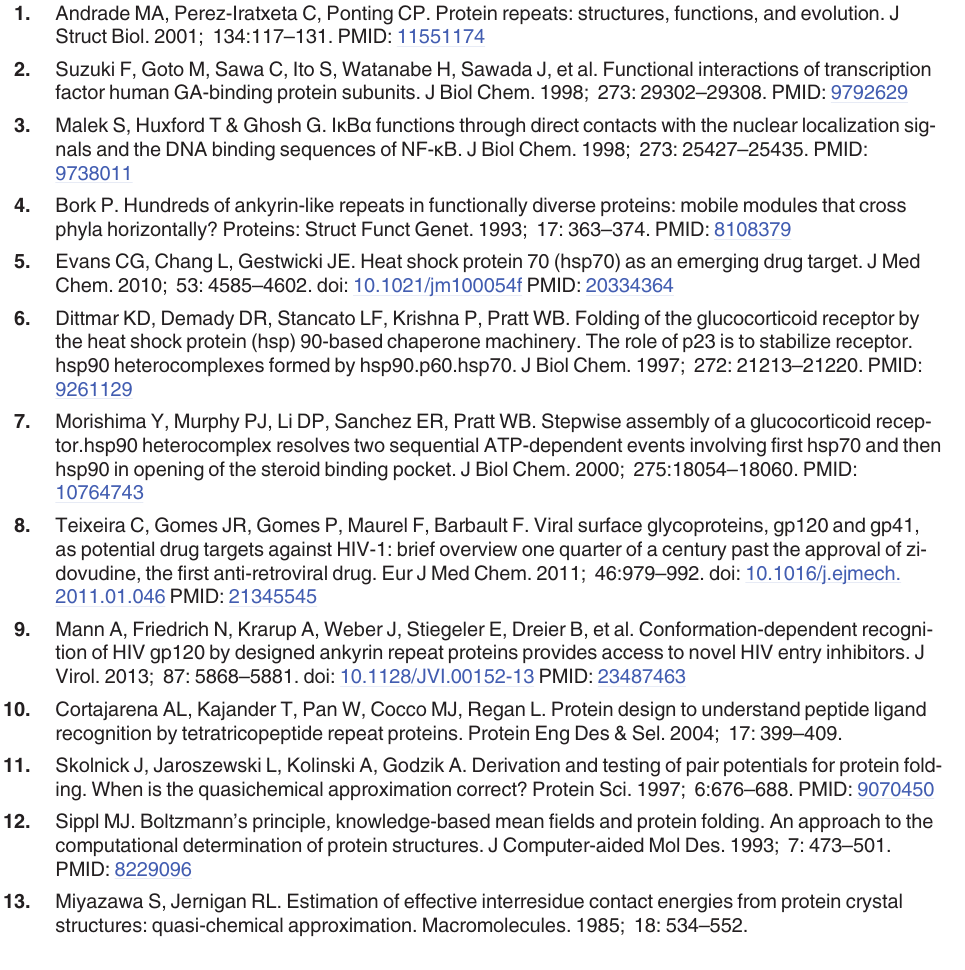
S1 Table. Statistical scores of multiple decoy proteins with different second structures. (PDF) S2 Table. Comparison of kinetic energies and RAPDF scores of globular proteins.